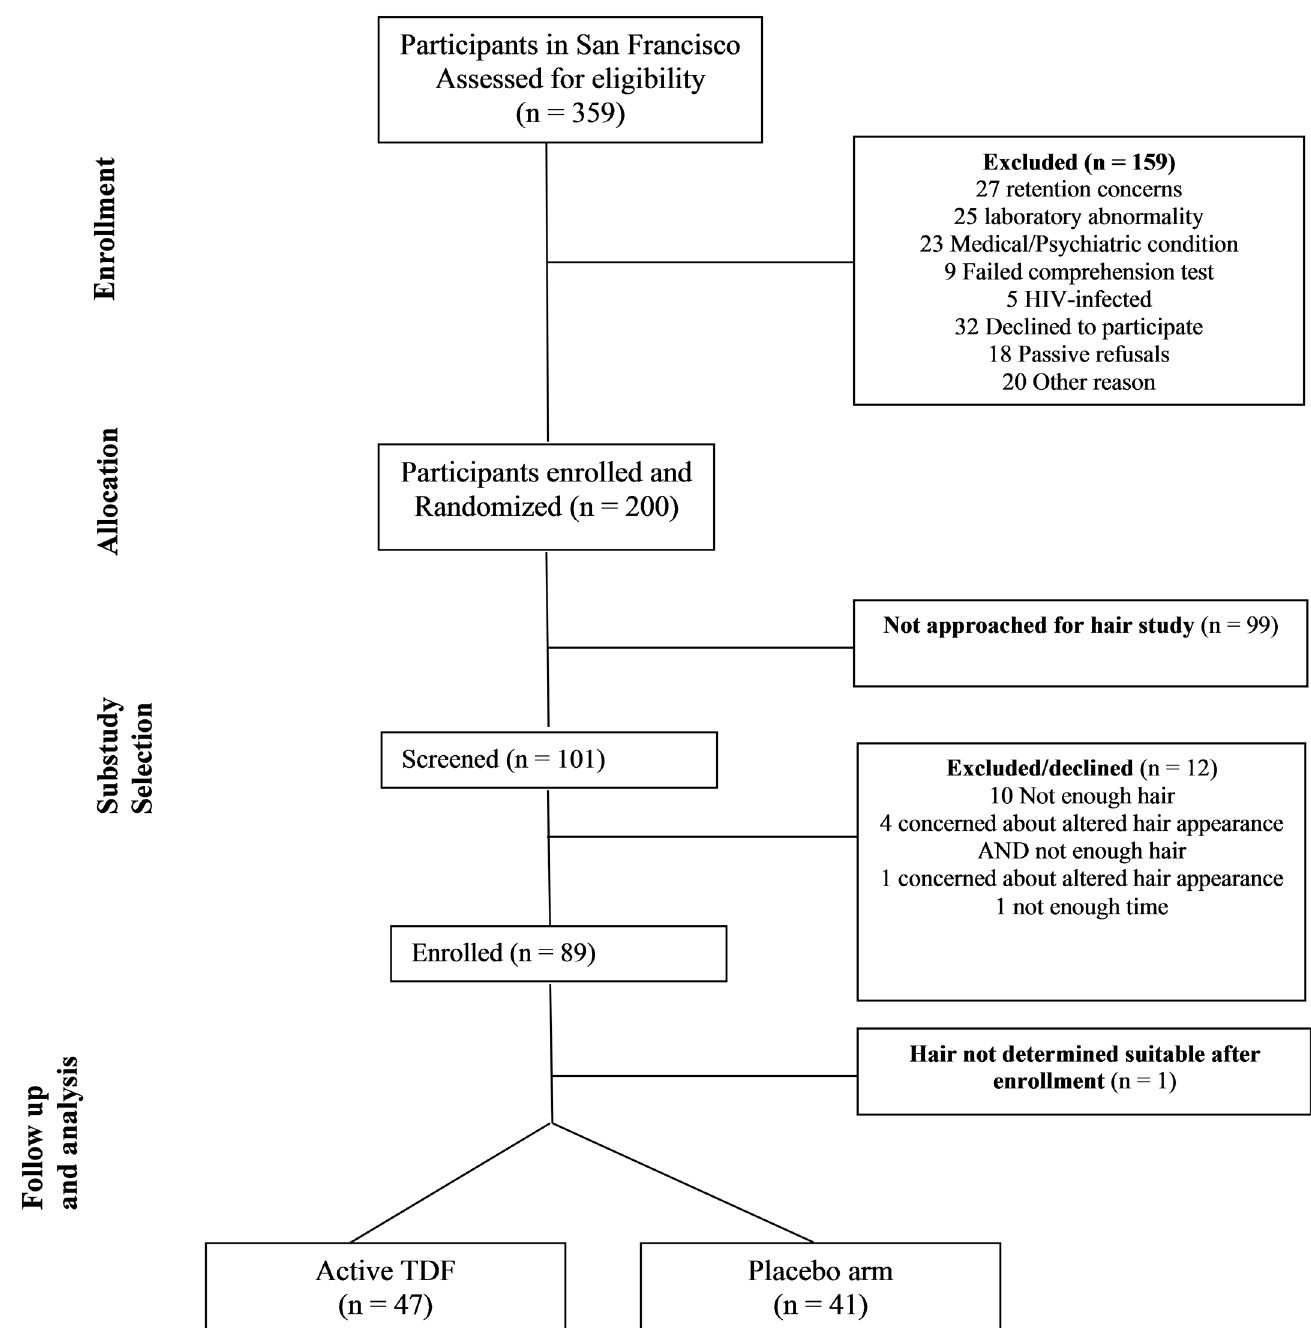
Fig 1. Study design and participant disposition. Drug was detected in plasma, PBMCs, and hair in almost all active arm participants, and not detected in almost all placebo arm participants (Table 2). One participant random- ized to the placebo arm had detectable drug concentrations in all three biomatrices collected and measured on the same study day. When hair and plasma samples were obtained